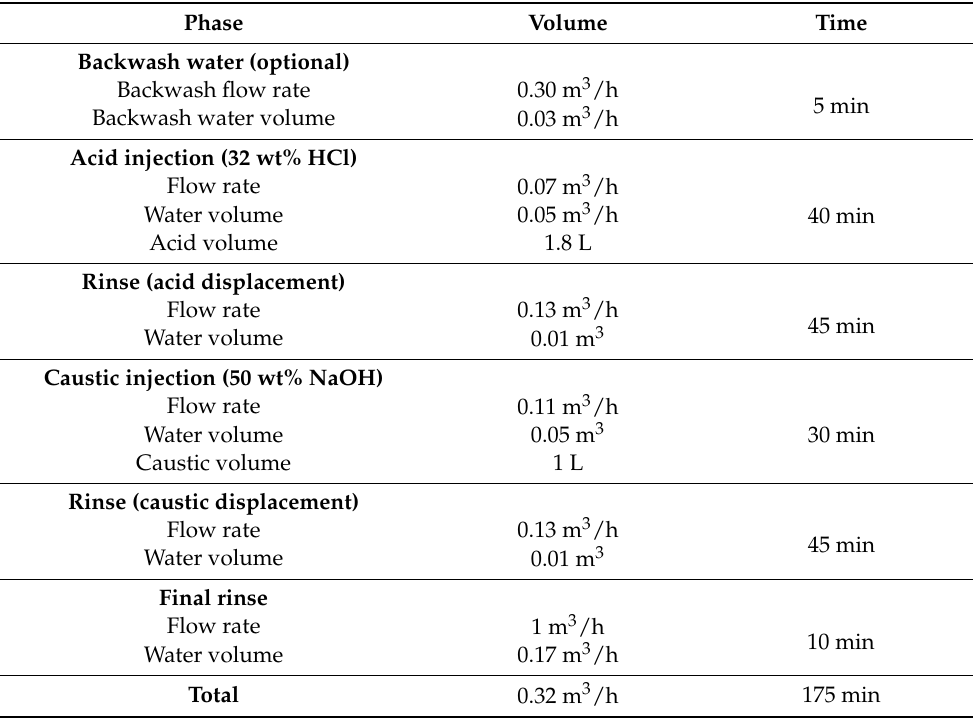
Table A1. Regeneration procedure suggested for AmberLite TM PWA10.